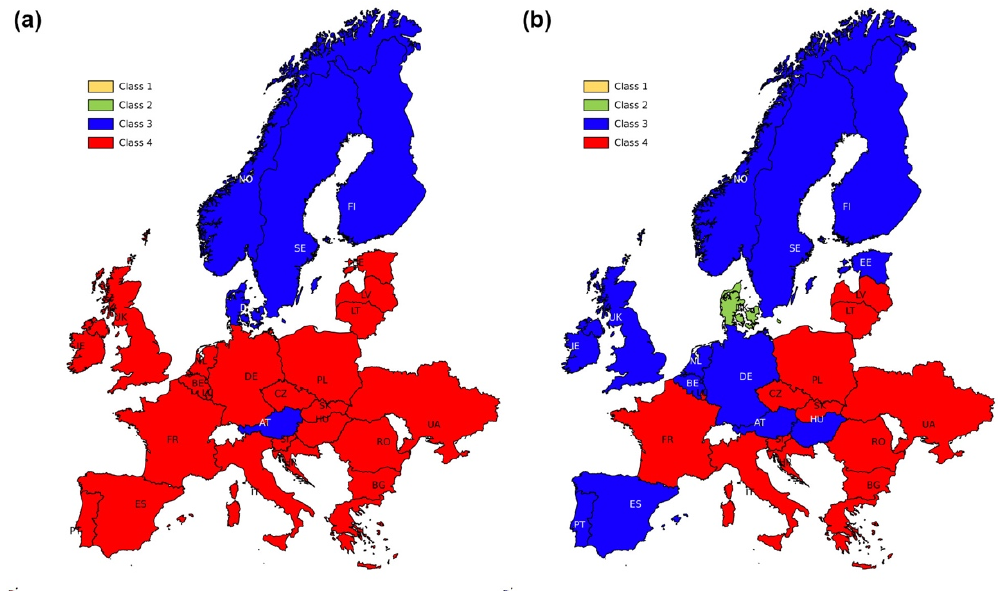
Figure 8. Classification results (VMCM) of European countries for real pattern (UK) and anti-pattern (UA) of 2018: ( a ) 2001; ( b ) 2009.